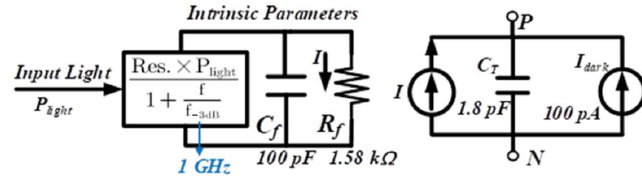
Figure 3. Compact equivalent circuit model of PD.